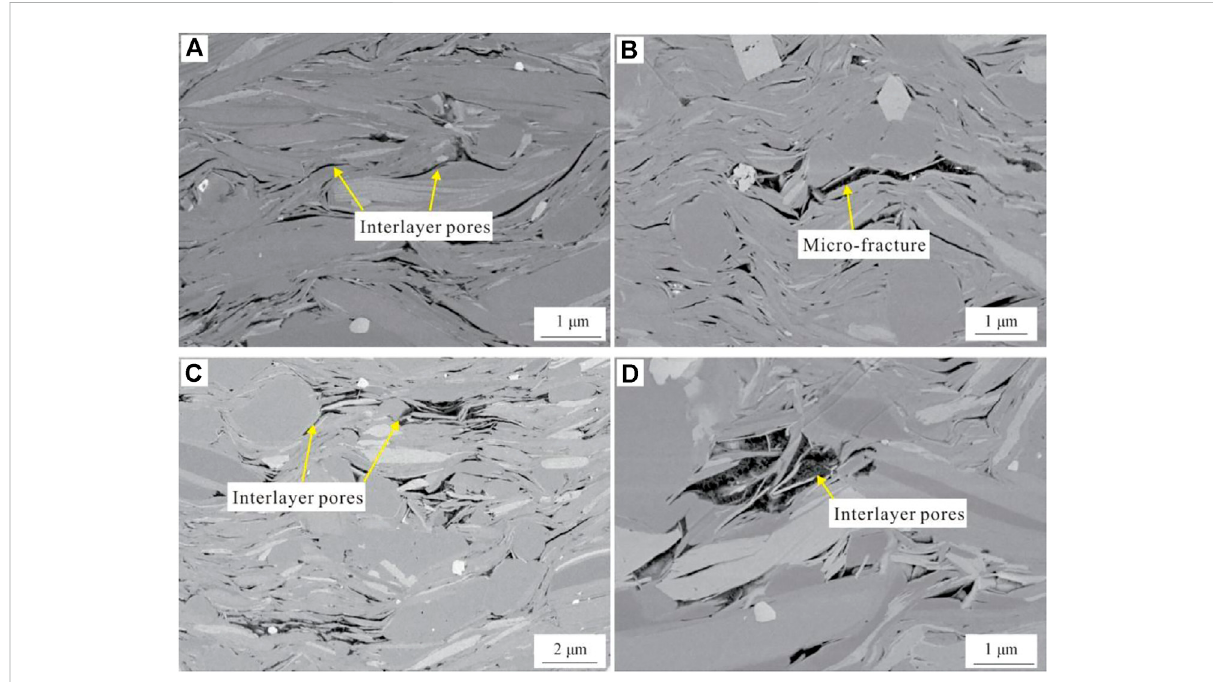
FIGURE 1 Developmentcharacteristics of interlayer poresand microfractures intheZiliujing Formation shale in theSichuan Basin (Liuet al.,2021). Notes: (A) Well F1, 2736.3 m; (B) Well X101, 2149.77 m; (C) WellX101, 2269.94 m; (D) Well Y30, 4007.13